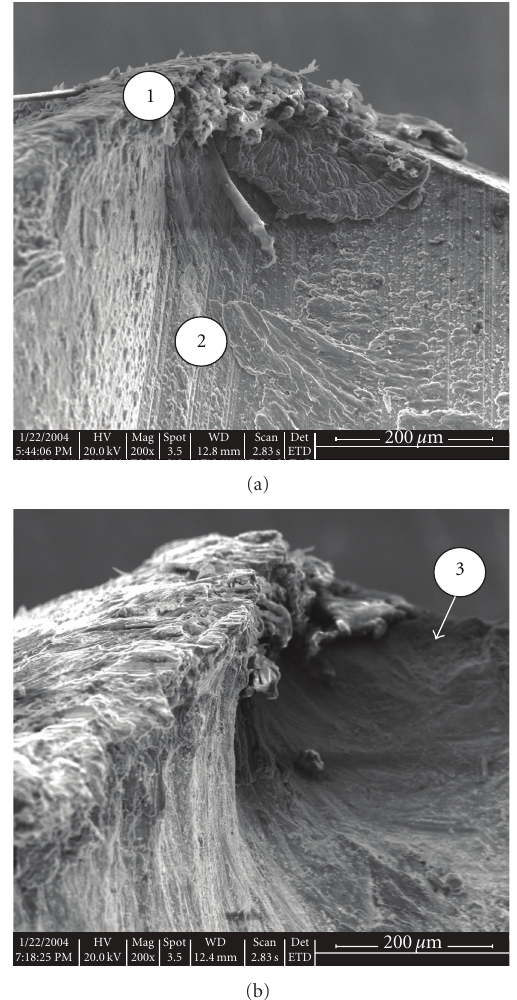
Figure 8: SEM images of the coloured zone close to the sharp end of two drills after (a) 25 holes and (b) 30 holes. Cutting speed, 20m/min.